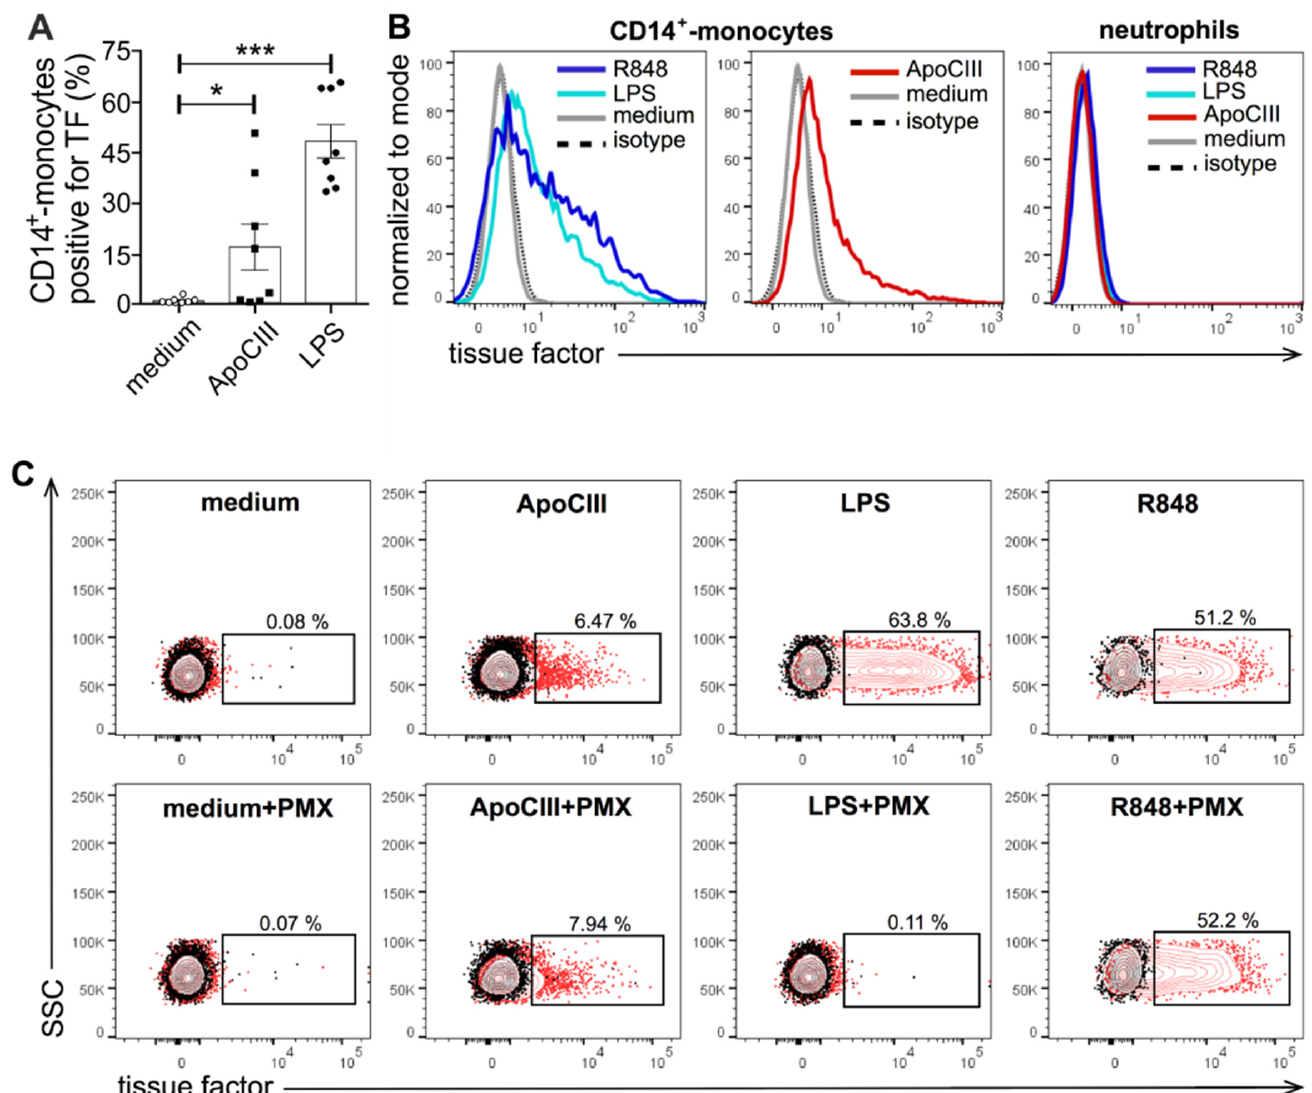
Figure 3. Expression of surface TF in human CD14 + -monocytes and autologous neutrophils exposed to ApoCIII. Human CD14 + -monocytes ( A – C ) and autologous neutrophils ( B ), purified as described in Section 4, were incubated for 3 h in the absence (medium) or presence of 50 µ g/mL ApoCIII, 5 µ M R848 or 0.1 and 1 µ g/mL LPS for CD14 + -monocytes and neutrophils, respectively. In selected experiments, the stimuli were preincubated with 20 µ g/mL polymyxin B (PMX) before their addition to the cells ( C ). Cells were then stained for surface TF expression by FACS as described in Section 4. Panel A depicts the percentage of TF + CD14 + -monocytes (mean ± SEM, n = 8). Data were analyzed by one-way ANOVA followed by the Holm–Sidak post hoc test. * p < 0.05; *** p < 0.001. Panel B displays representative histograms showing the expression of surface TF by CD14 + -monocytes and neutrophils incubated with ApoCIII, LPS and R848 as compared to isotype control antibodies. Panel C displays representative flow cytometry plots showing the percentage of TF + CD14 + -monocytes (represented as red dots) incubated with ApoCIII, LPS and R848, in the absence or presence of PMX, as compared to the isotype control antibodies (represented as black dots).